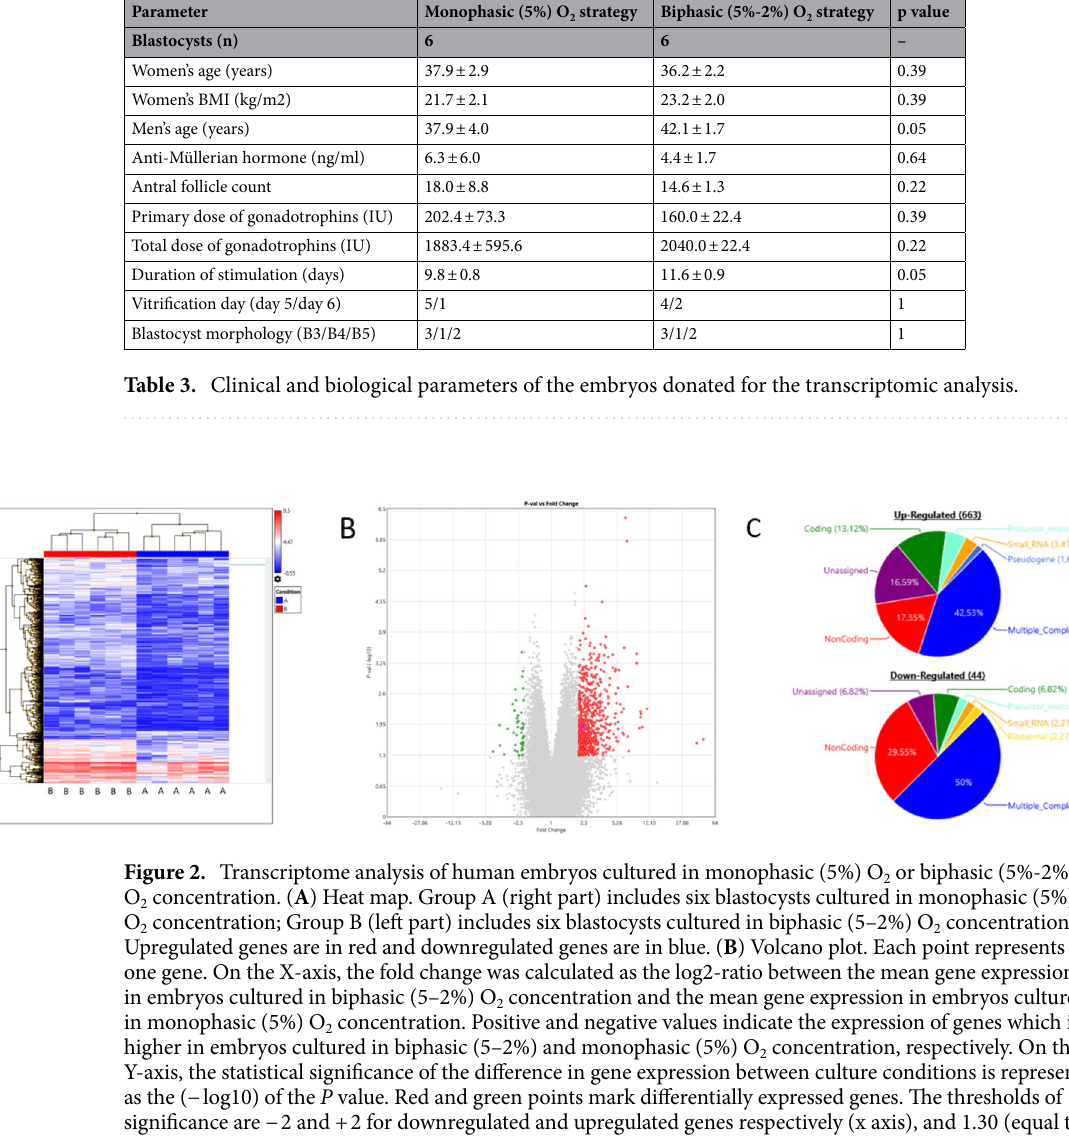
2 concentration. Conversely, 44/707 (6.2%) RNAs were downregulated in blastocysts cul- tured in biphasic (5–2%) O 2 conditions. Multiple complex RNAs represented approximately 50% of the differ- entially expressed RNAs (Fig. 2C). Coding and non-coding RNAs represented 13.12% and 17.3% of upregulated RNAs, respectively (Fig. 2C). Coding and non-coding RNAs represented 6.82% and 29.5% of downregulated RNAs, respectively (Fig. 2C). The top-five upregulated genes were VN1R84P (vomeronasal 1 receptor 84 pseu- dogene, × 8,sevenfold, p = 0.0004, Multiple Complex), SNORD14E (small nucleolar RNA, C/D box 14E, × 6.55-